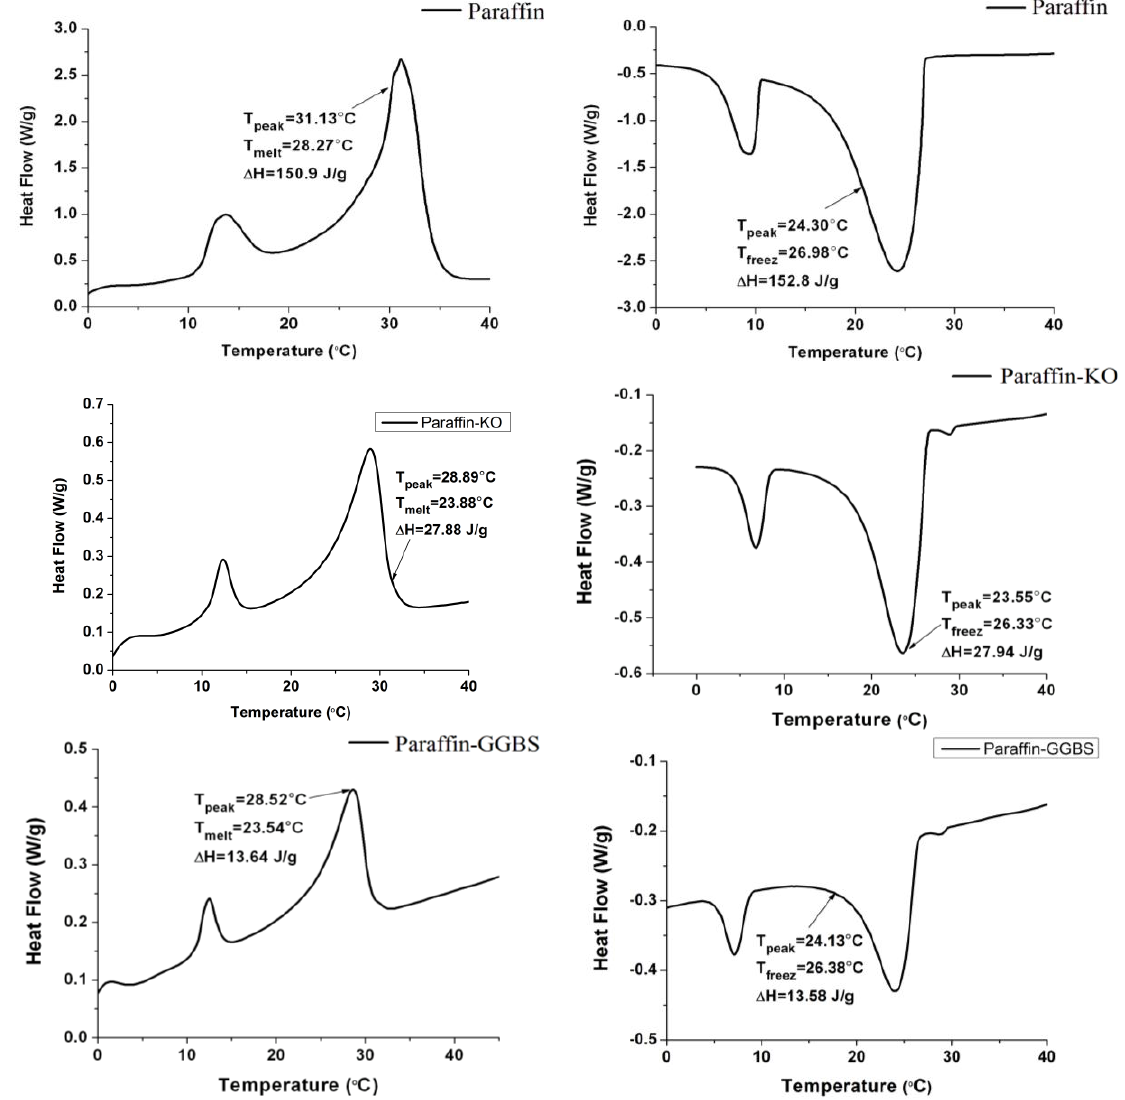
Figure 6. DSC thermograms of the paraffin and